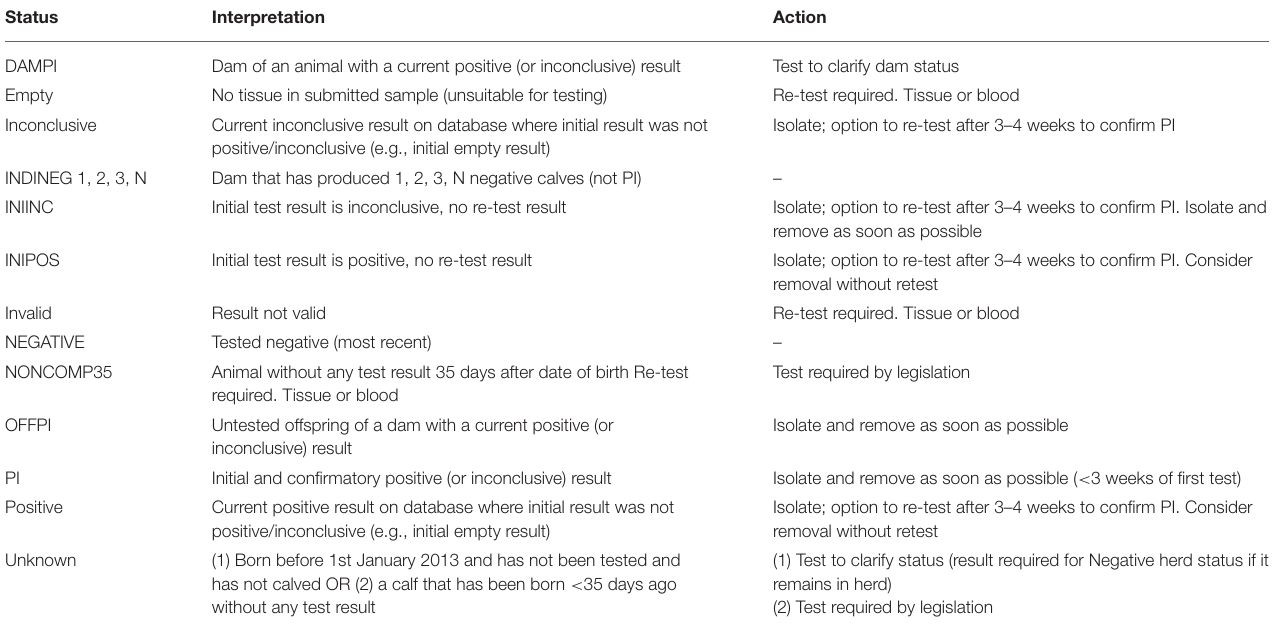
TABLE 1 | Summary of the 13 possible statuses assigned to each animal in the programme database in relation to its BVD status, and the interpretation and action recommended with each one. Status